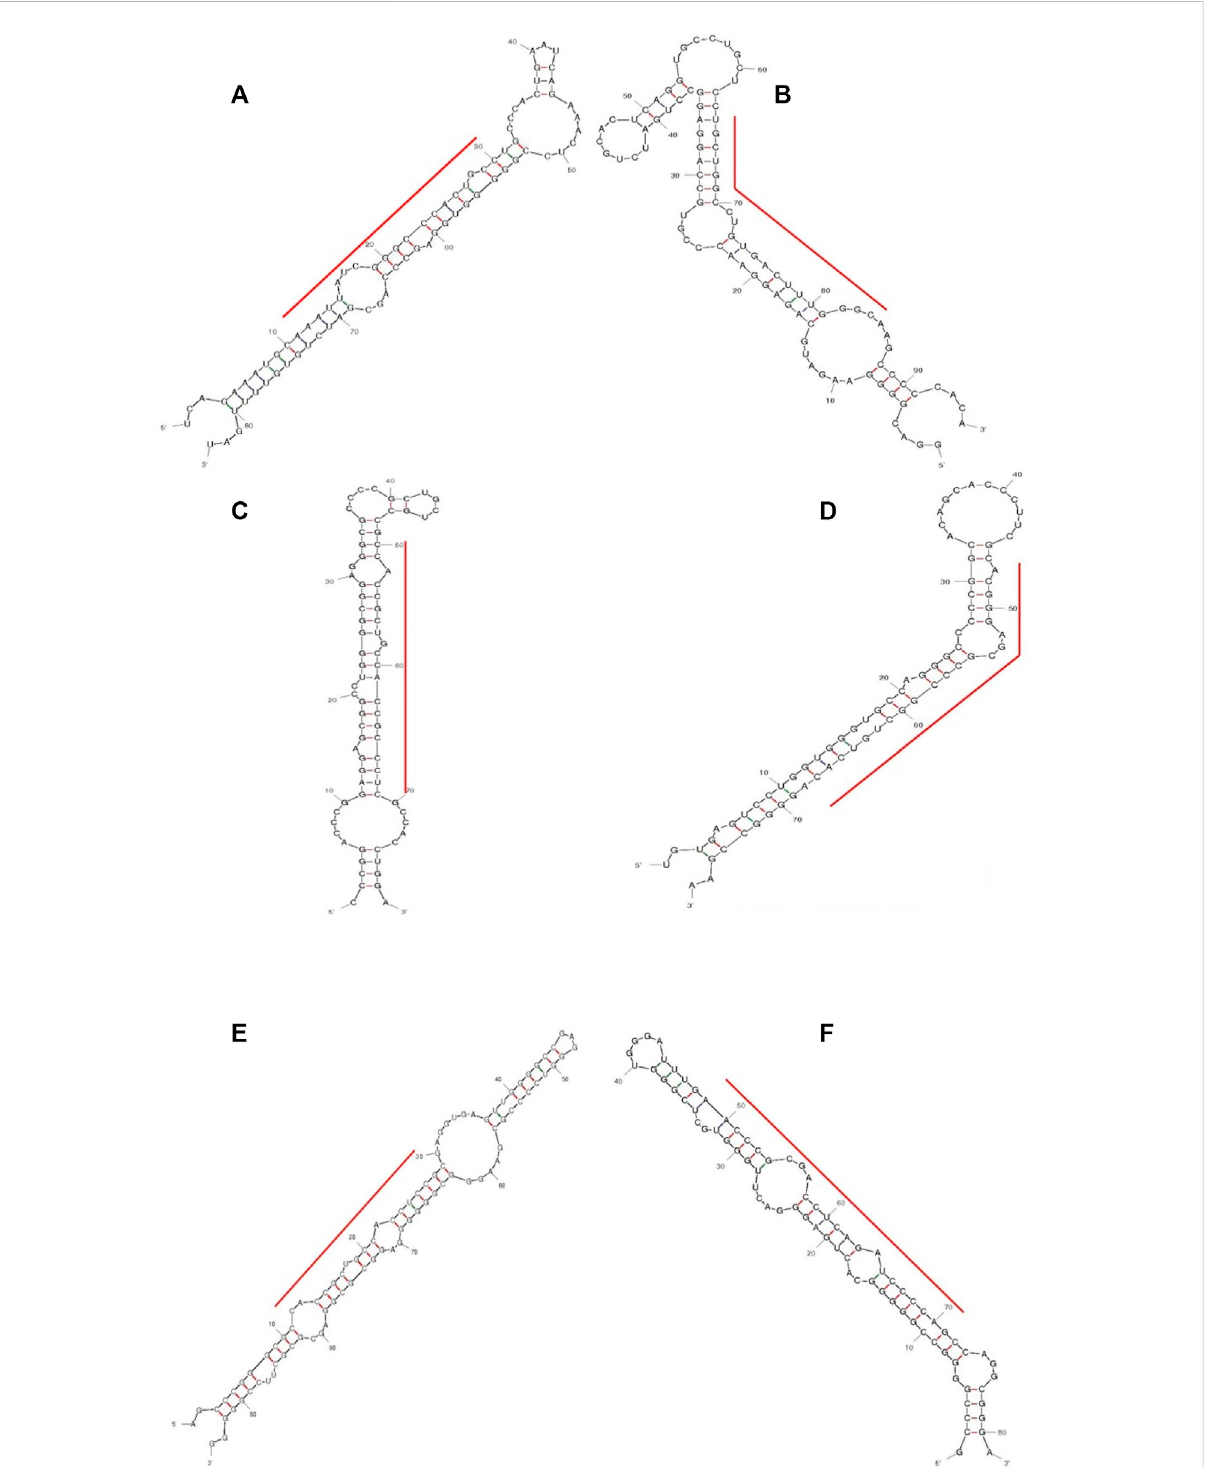
FIGURE 5 Predicted secondary structures of selected putative pri-miRNA sequences with high read counts from control (A – C) and 24 h of 83 μ M EGCG treatment (D – F) . (A) EGCG-MDAMB231-1, (B) EGCG-MDAMB231-2, (C) EGCG-MDAMB231-3, (D) EGCG-MDAMB231-11, (E) EGCG-MDAMB231-12, (F)